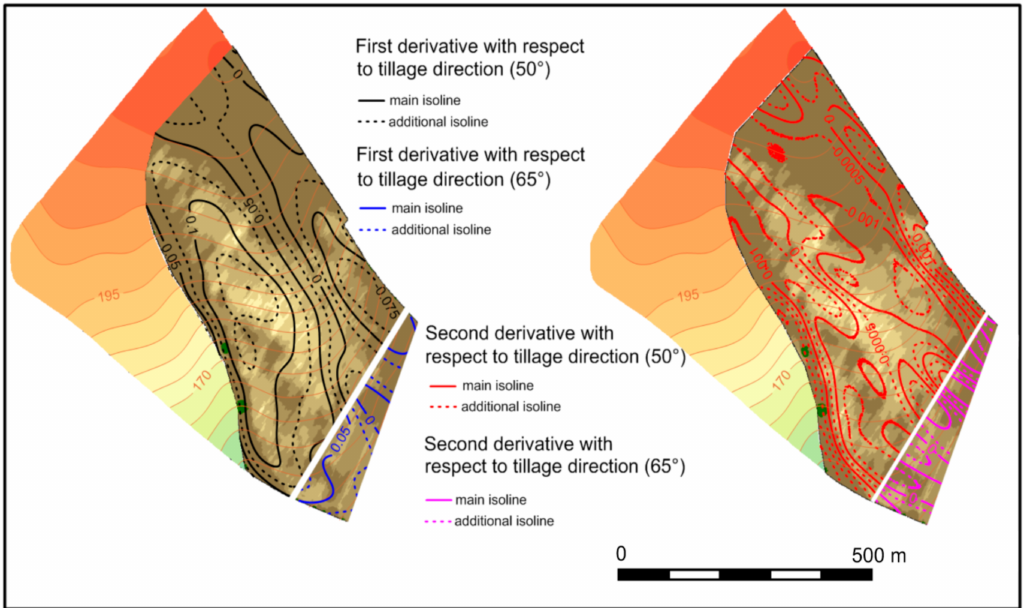
Figure 5. Overlay of the isoline field of the first-order (left image) and the second-order (right image) partial derivative of elevation with respect to past prevailing tillage direction displayed in Figure 1c compared with the erosion pattern obtained by object-based classification (background